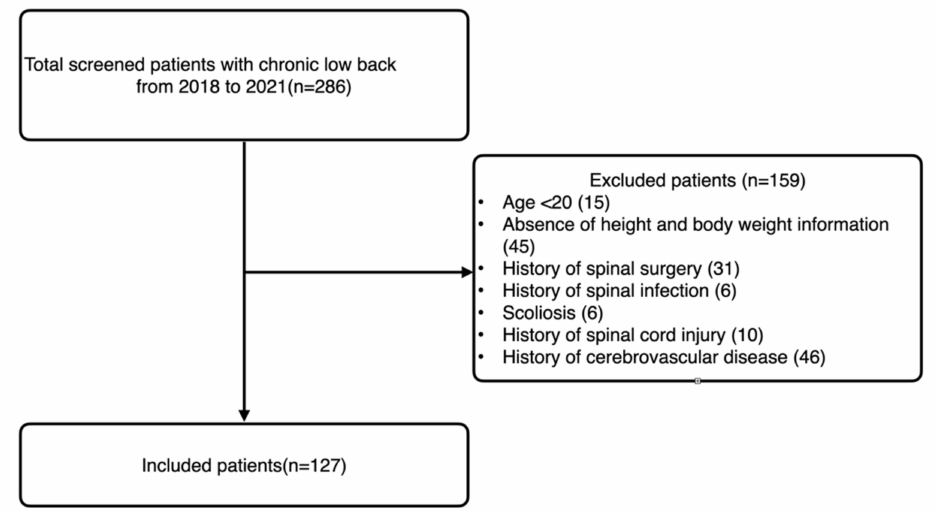
Figure 1. Flowchart of patient inclusion and